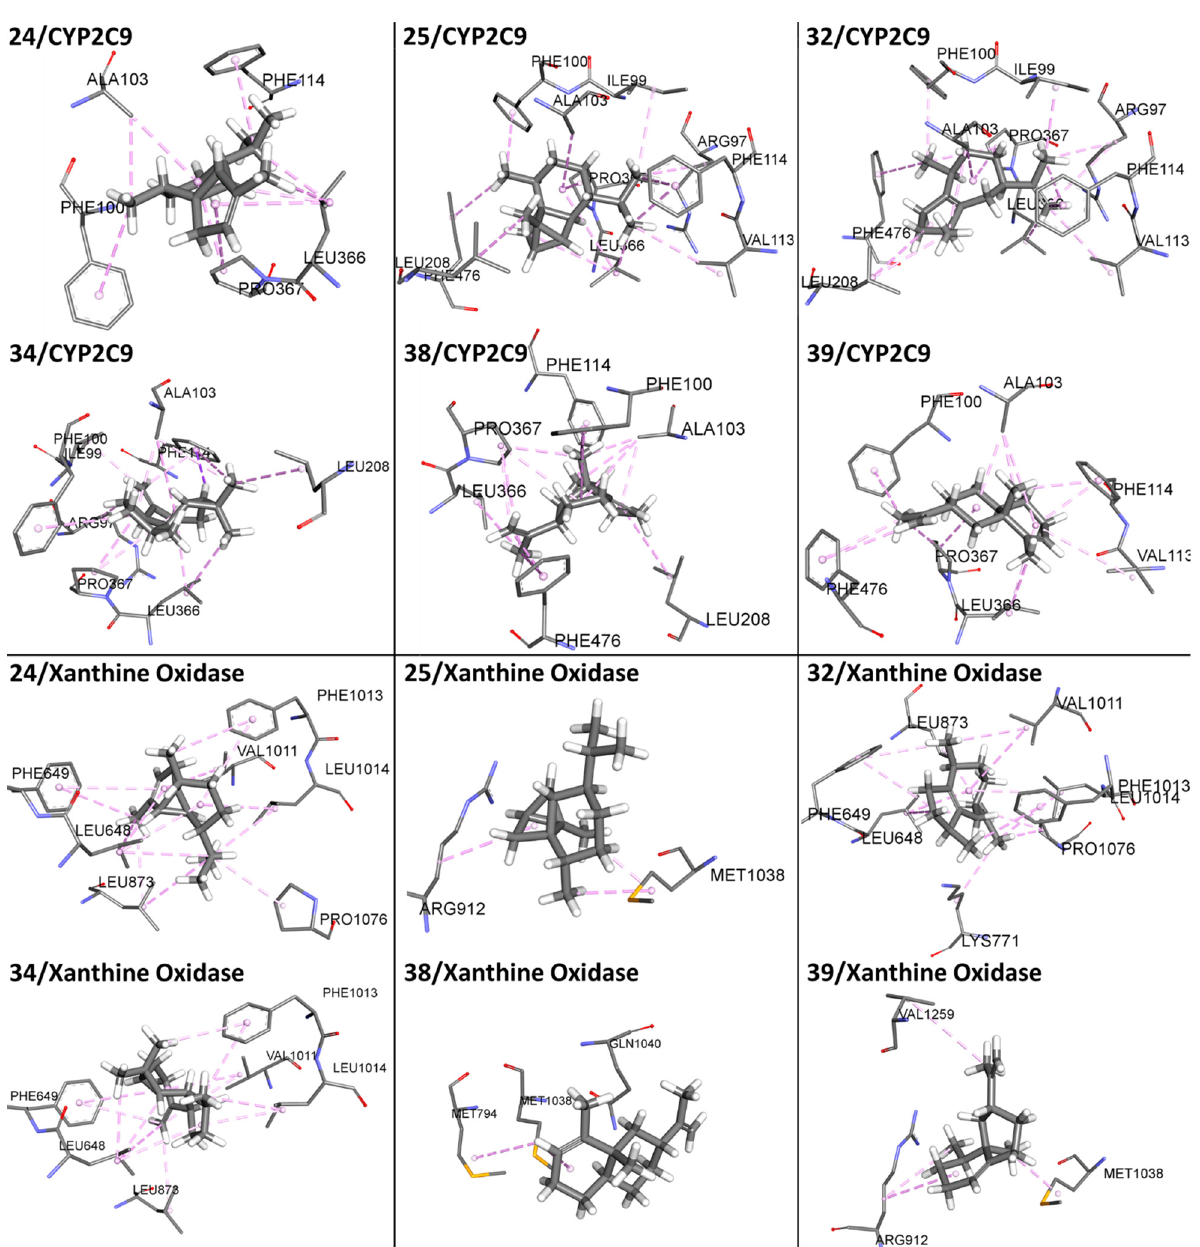
Figure 5. Molecular docking visualization for the best six compounds ( 24 , 25 , 32 , 34 , 38 , and 39 ) of VPEO bound to CYP2C9 and xanthine oxidase. The surrounding amino acid residues in the binding pocket of CYP2C9 and xanthine oxidase within 3Å are shown.